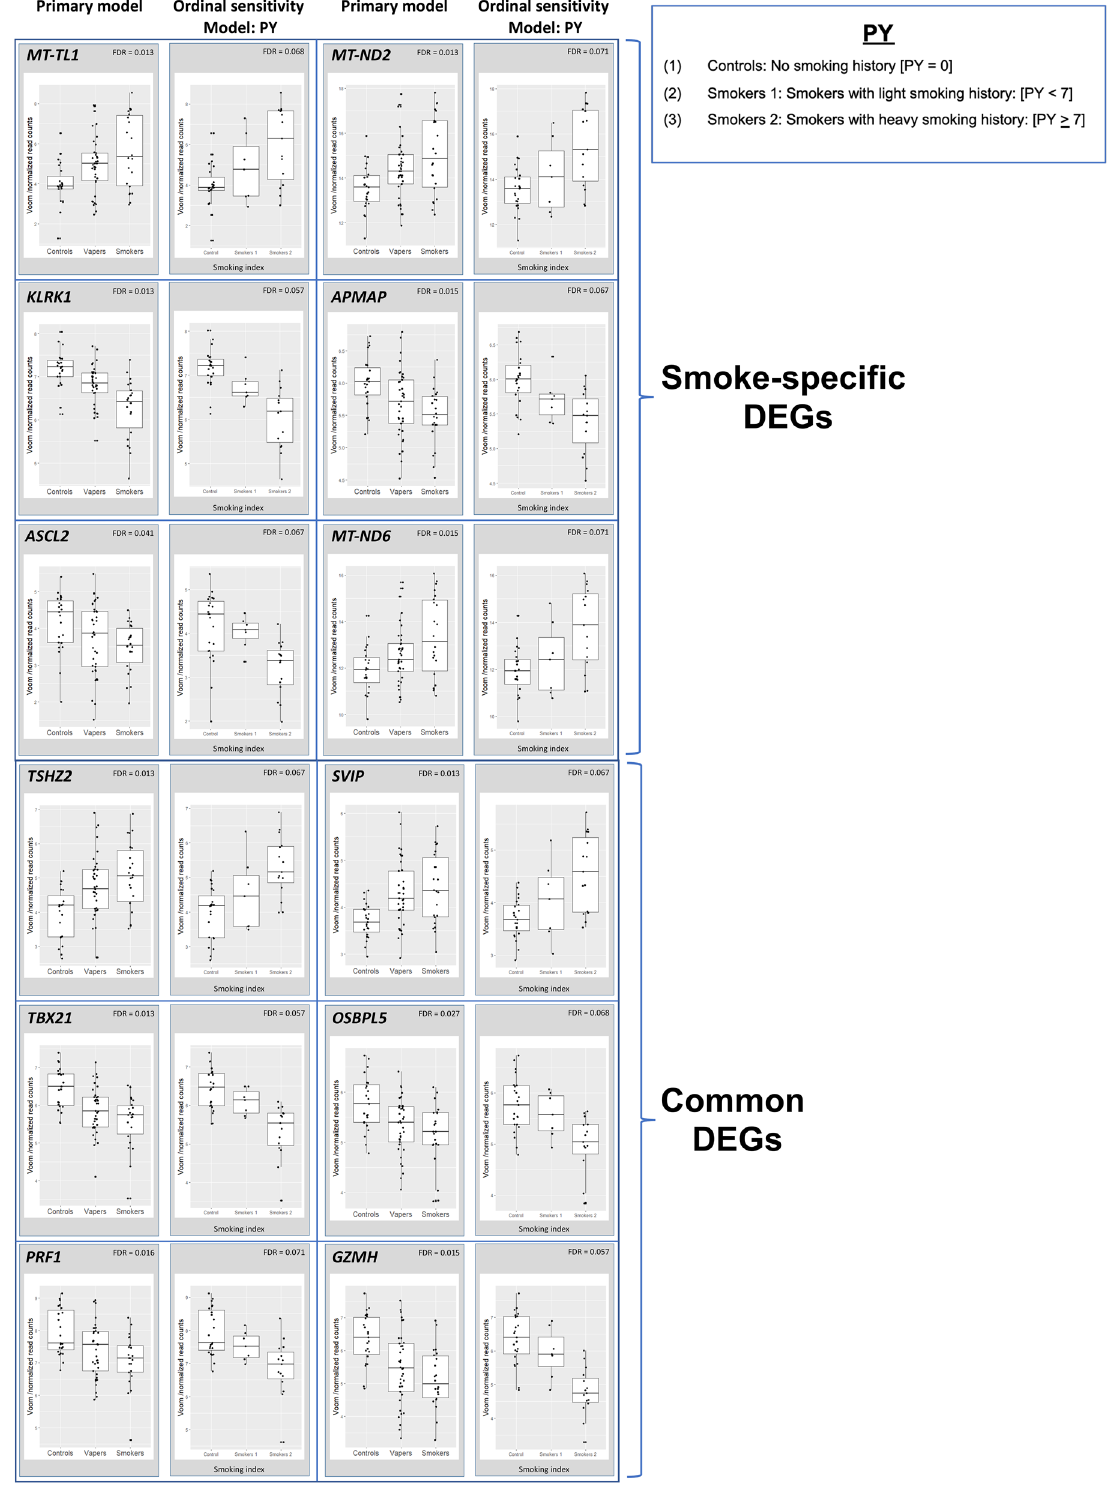
Figure 3. Visualization of the results of primary and ordinal sensitivity analyses—Smoking. Gene expression results for six smoke-specific DEGs (upper panel) and six common DEGs (lower panel), as determined by primary and PY sensitivity analyses, are shown. Concordant statistically significant differential expression results for target genes in primary and PY sensitivity analyses indicates that smoking dose ( i.e. , intensity and duration of smoking) is significantly associated with gene dysregulation in smokers. In the PY sensitivity model, smokers were divided in two categories, including Light smokers [Smokers 1: PY < 7], and Heavy smokers [Smokers 2: PY ≥ 7] in comparison to Controls [No smoking history: PY = 0] ( see , also legend for Fig.